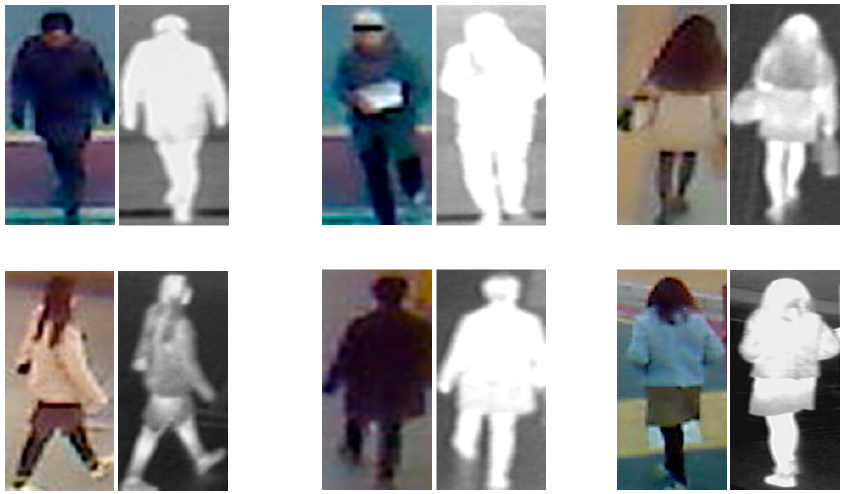
Figure 7. Examples of visible light and thermal image pairs of people in our collected database.